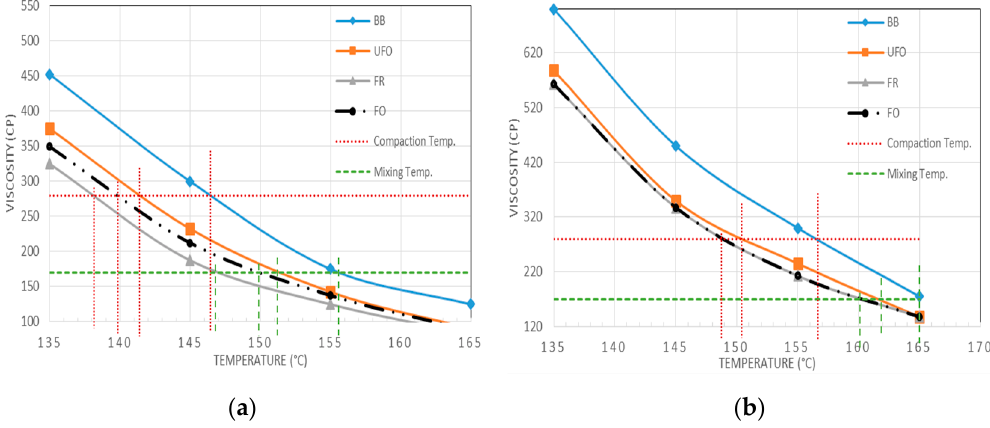
Figure 4. Viscosity variations in different binders: ( a ) Unaged condition and ( b ) RTFO aged. In-field mixing and compaction temperatures were selected based on the viscosity of binder.